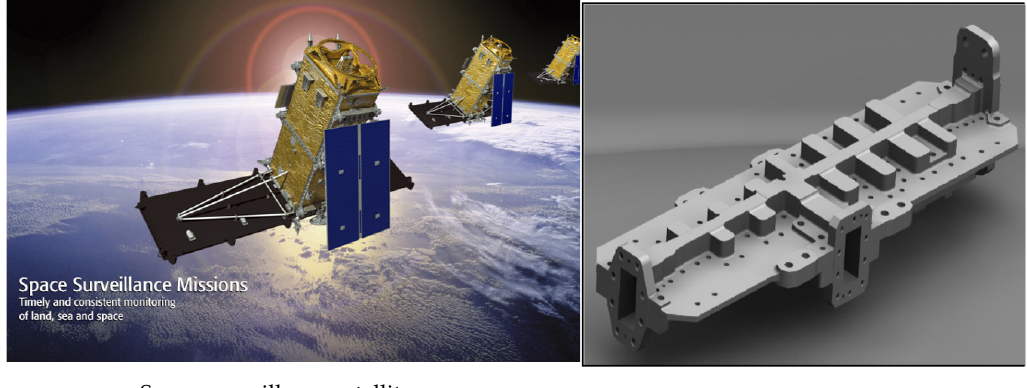
Figure 2. Some applications of rapidly solidified aluminum alloys [5].